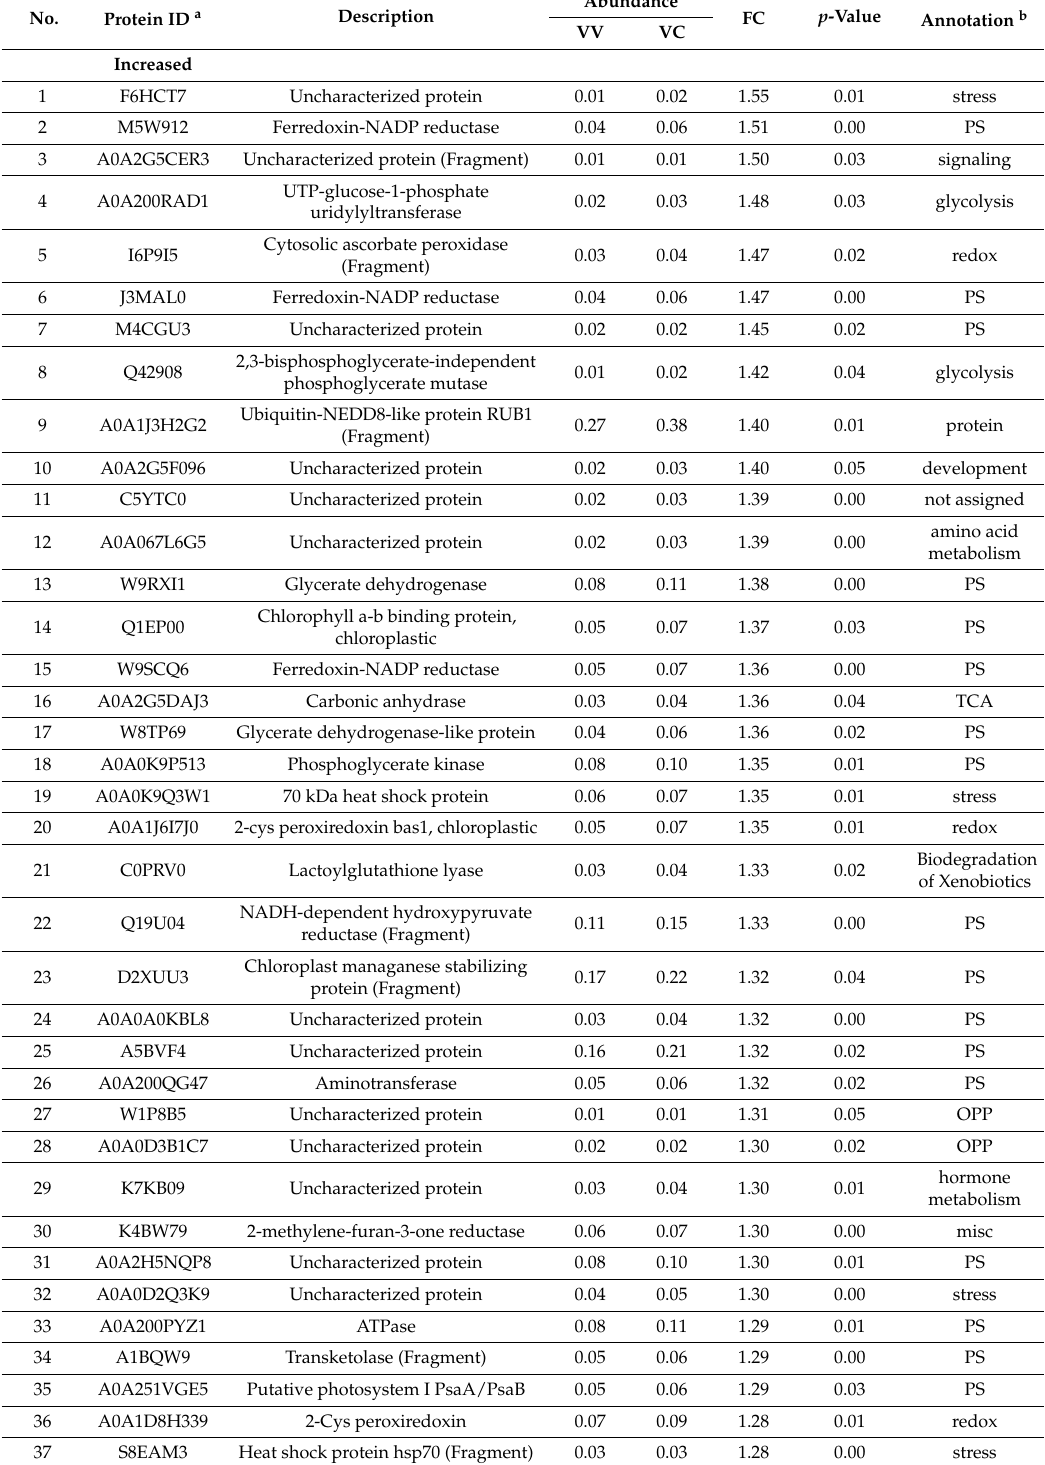
Table 1. Differential Expressed Proteins in Clematis terniflora DC. between VV and VC after HUV-B+D treatment (1.55 > fold change >